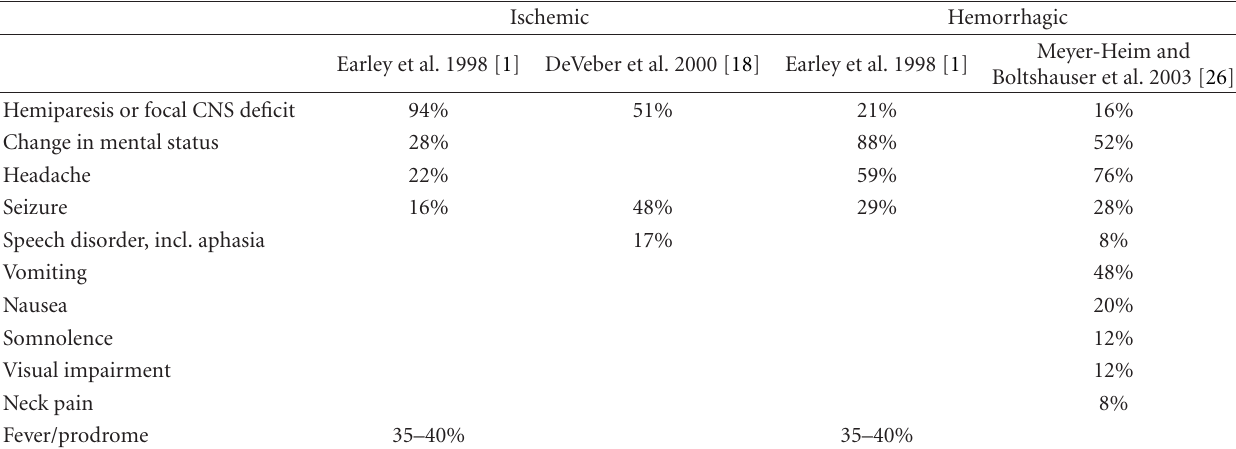
Table 1: Clinical presentation of pediatric ischemic and hemorrhagic strokes. Ischemic